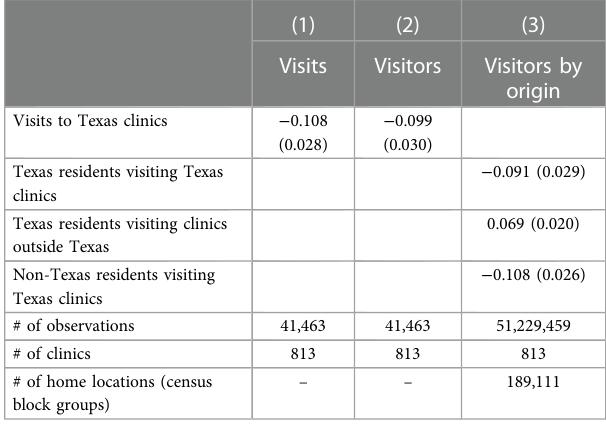
TABLE 2 Difference-in-differences